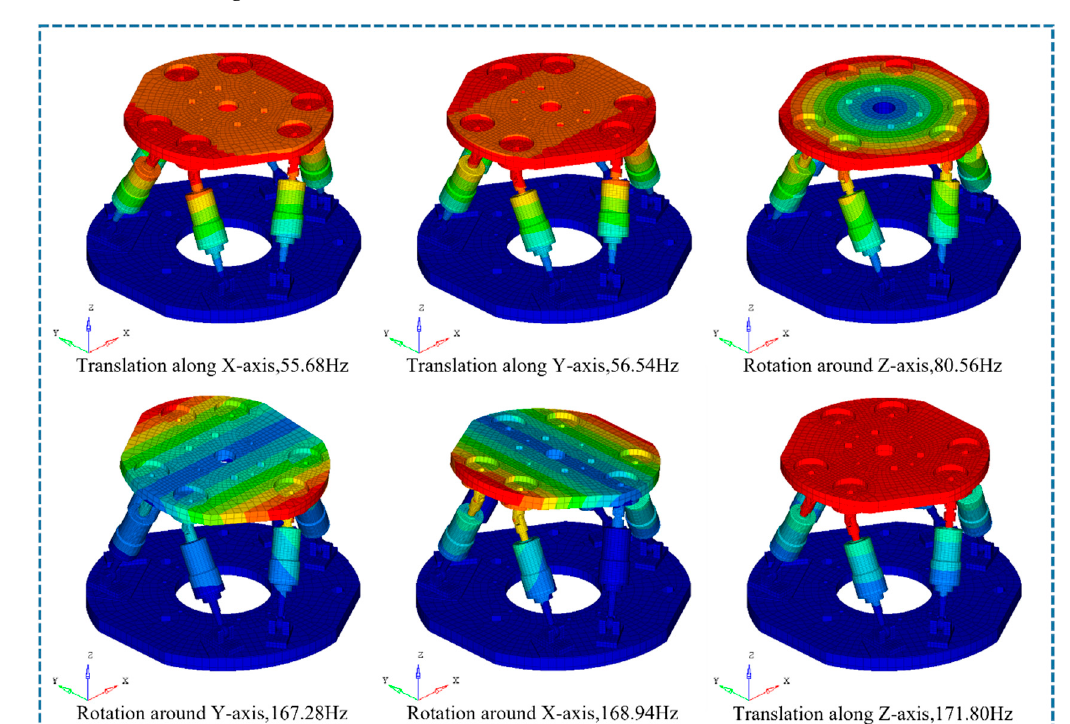
Figure 10. Modal analysis results of the SVIP.